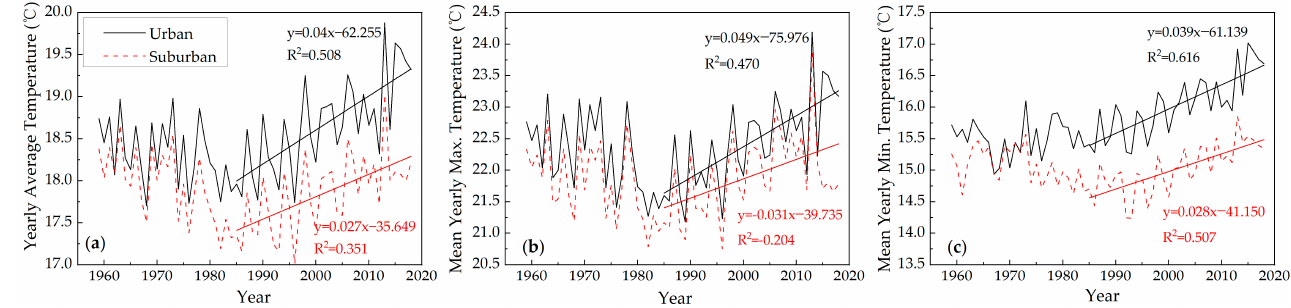
Figure 4. Temperature for urban and rural areas, 1959–2018: ( a ) yearly average temperature; ( b ) mean annual daily maximum temperature; ( c ) mean annual daily minimum temperature.